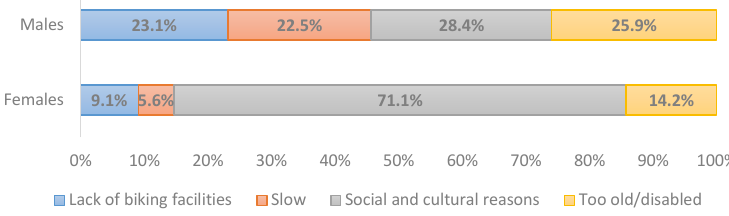
Figure 4. Reasons for not cycling among female and male respondents in the Cairo sample .